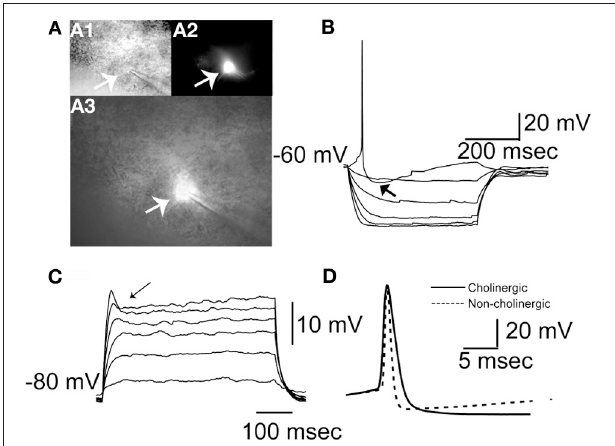
FIGURE 3 | Morphological and physiological identification of GFP expressing neurons in the BF. (A) Morphology of a typical GFP + neuron. (A1) Image of the neuron taken with DIC. (A2) Same neuron imaged with epifluorescence illumination showing GFP fluorescence. (A3) Overlay of images in A1 and A2 . Arrows in A1 , A2 , and A3 indicate the cell being patched. (B) A cholinergic neuron at rest responding to negative and positive square pulses ranging between − 100 and 20pA in 20pA increments. Zero pA step not shown. Note the prominent AHP following the single spike (indicated with arrow), and anomalous inward rectification at negative voltages. (C) The same neuron recorded in the presence of 1 μ M TTX from a membrane potential of − 80mV in response to positive square current pulses from 20 to 120pA in 20pA increments. Note the voltage hump (indicated by arrow) and the outward rectification in the positive direction. (D) A representative cholinergic neuron spike (thick continuous line) and a spike from a non-cholinergic neuron (dashed line). Note the wide spike of the cholinergic